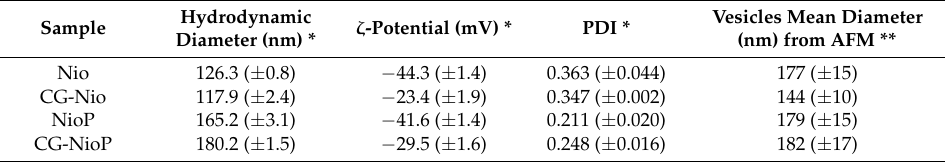
Table 2. DLS and AFM analyses on niosomes in presence and absence of pentamidine and chitosan glutamate. * Values represent the mean ± standard deviation of n = 3 niosome sample measurements. ** Values represent the mean ± standard deviation calculated on at least 15 different niosomes.